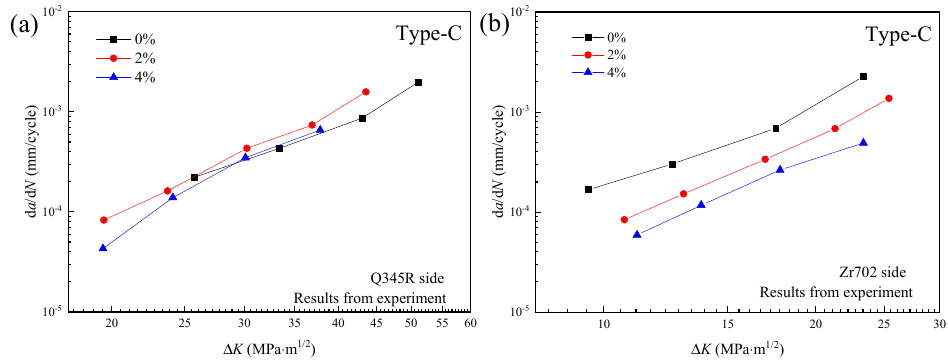
Figure 11. Effect of pre-strain on d a /d N on both sides: ( a ) Q345R side, ( b ) Zr702 side. Figure 12 shows the change in Δ K and d a /d N of the overall crack with the pre-strain level. Figure 12a shows that the overall Δ K of the 0% pre-strain level is the lowest under the same overall crack length. This is because the resistance to crack growth of the Zr702 side under 0% pre-strain is lower than that of the other two groups, so the crack preferen- tially propagates on this side and always leads the crack length of the Q345R side. The stress at the crack tip is released and the Δ K is lower than that of the other two groups. Although the Δ K of the Q345R side at the 0% pre-strain level is slightly higher than that of the other two groups, the Δ K of the overall crack is still lower than the 2% and 4% pre- strain. The d a /d N– Δ K curves of the overall crack under different pre-strain levels in Figure 12b show that the increase in pre-strain has a restraining effect on the overall crack growth